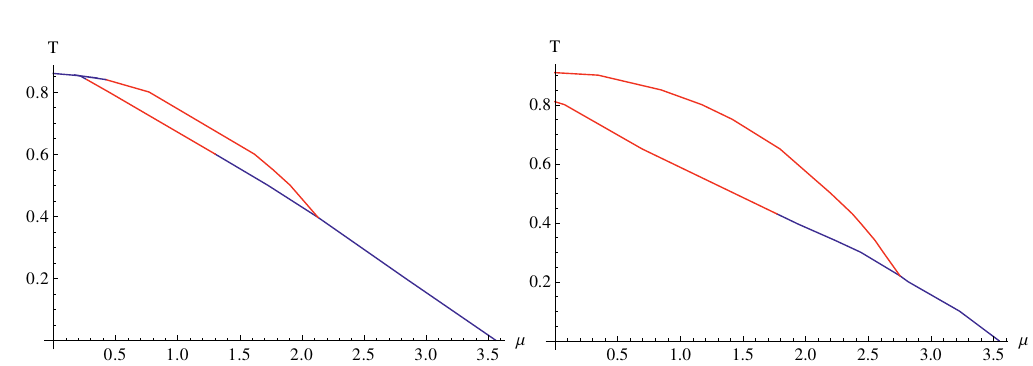
Figure 5. Sample phase diagrams for theories with none zero α ( α = 2 . 2 ,α = 3) [4].